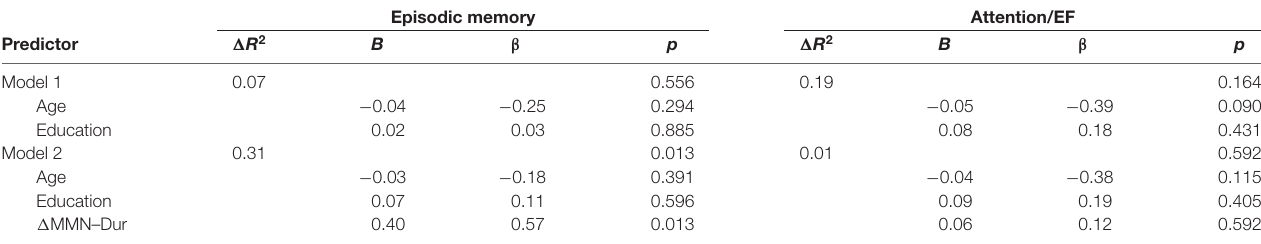
TABLE 4 | Associations between baseline auditory memory trace decay and follow-up episodic memory as well as executive functions accounting for age and education. Episodic